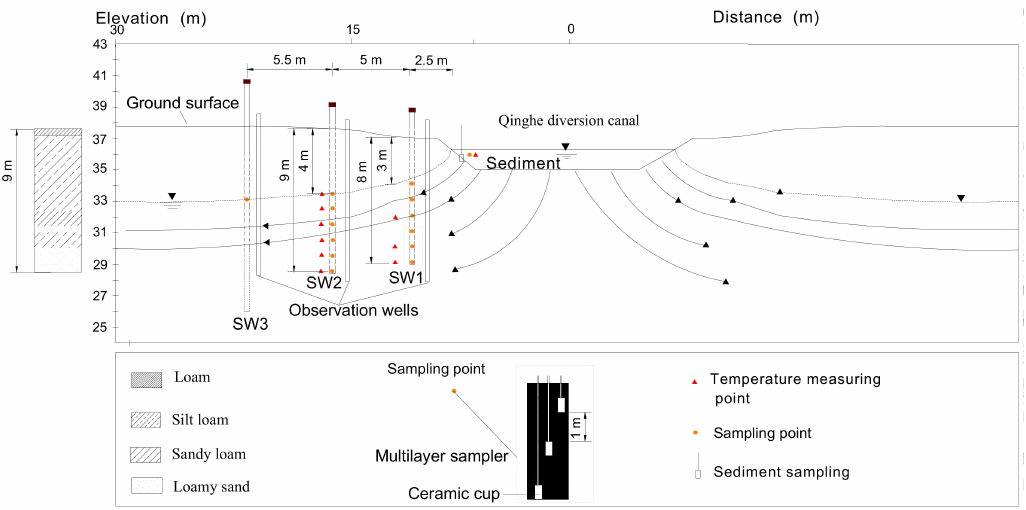
Figure 3. Schematic of the sampling points at the sampling section.